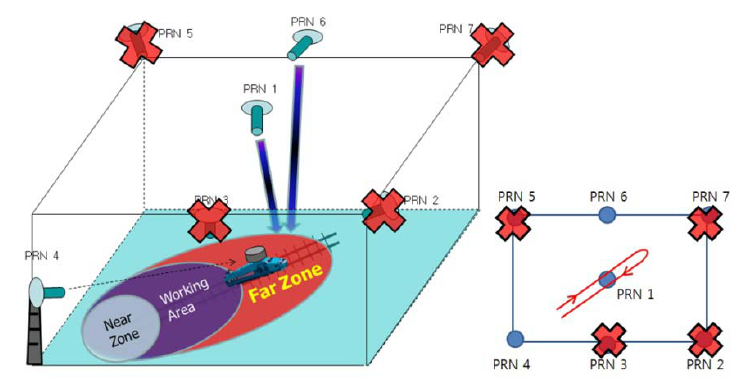
Figure 21. Test 2: Test setup and user trajectory.